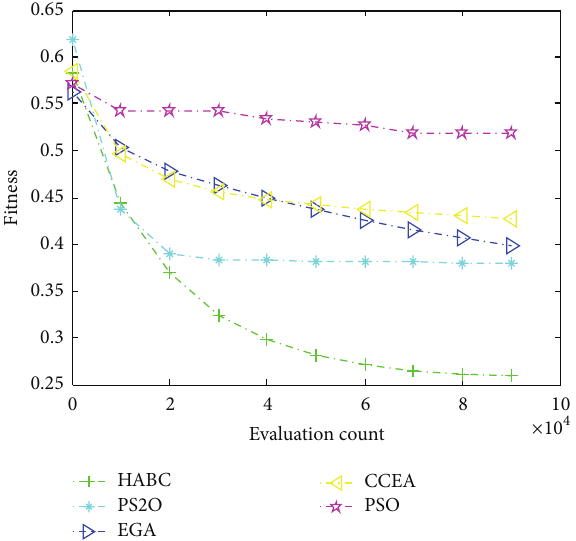
Figure 15: The convergence process of all algorithms with the combined objective function 𝑓 𝑚 on Cd500.